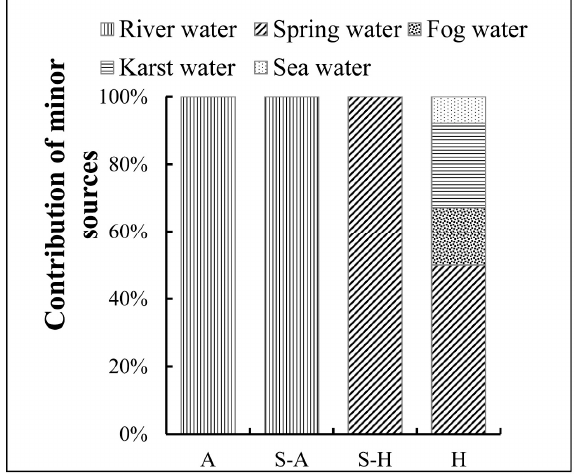
Figure 7. Contribution of minor water sources. A: Arid region; S-A: Semi-arid region; S-H: Semi- humid region; H: humid region.